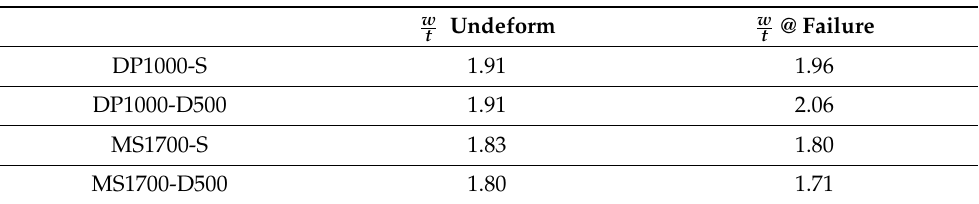
Table 2. Variability of the width/thickness ratio for static and dynamic tests of DP1000 and MS1700 steels.